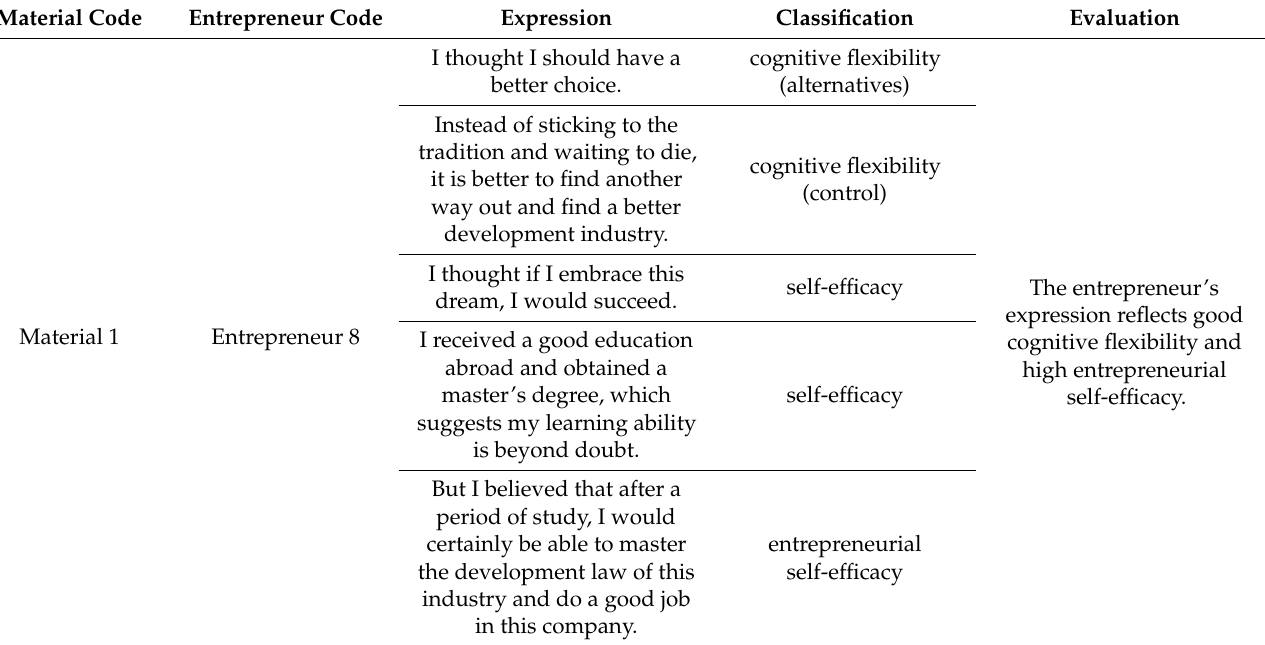
Table 1. Interview material distilling